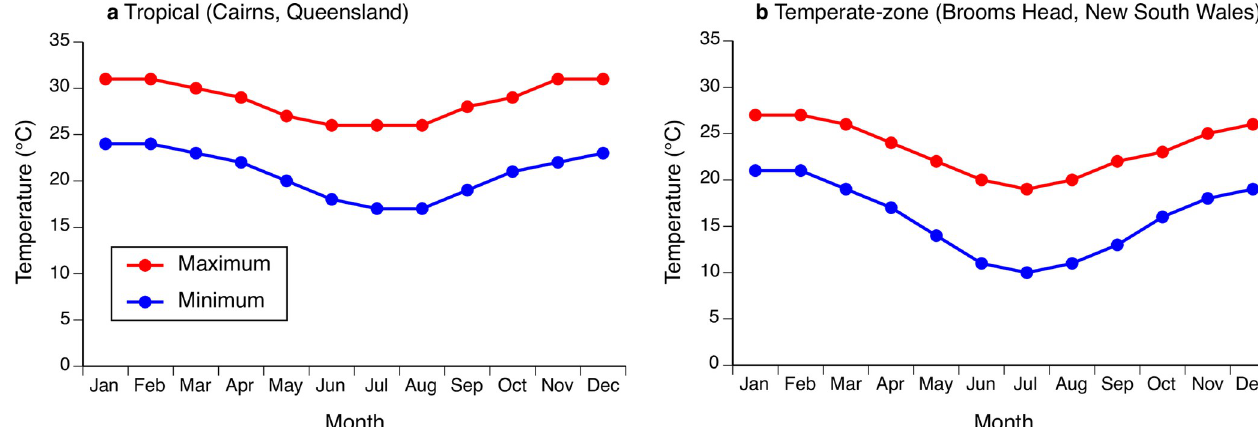
Fig 3. Average monthly air temperatures (maxima and minima) for study sites. ( a ) tropical Australia (Cairns, Queensland), and ( b ) temperate-zone Australia (Brooms Head, New South Wales) from which cane toads ( Rhinella marina ) were collected, to provide offspring tested in the current study. Data from http://www.bom.gov.au (accessed 22 July